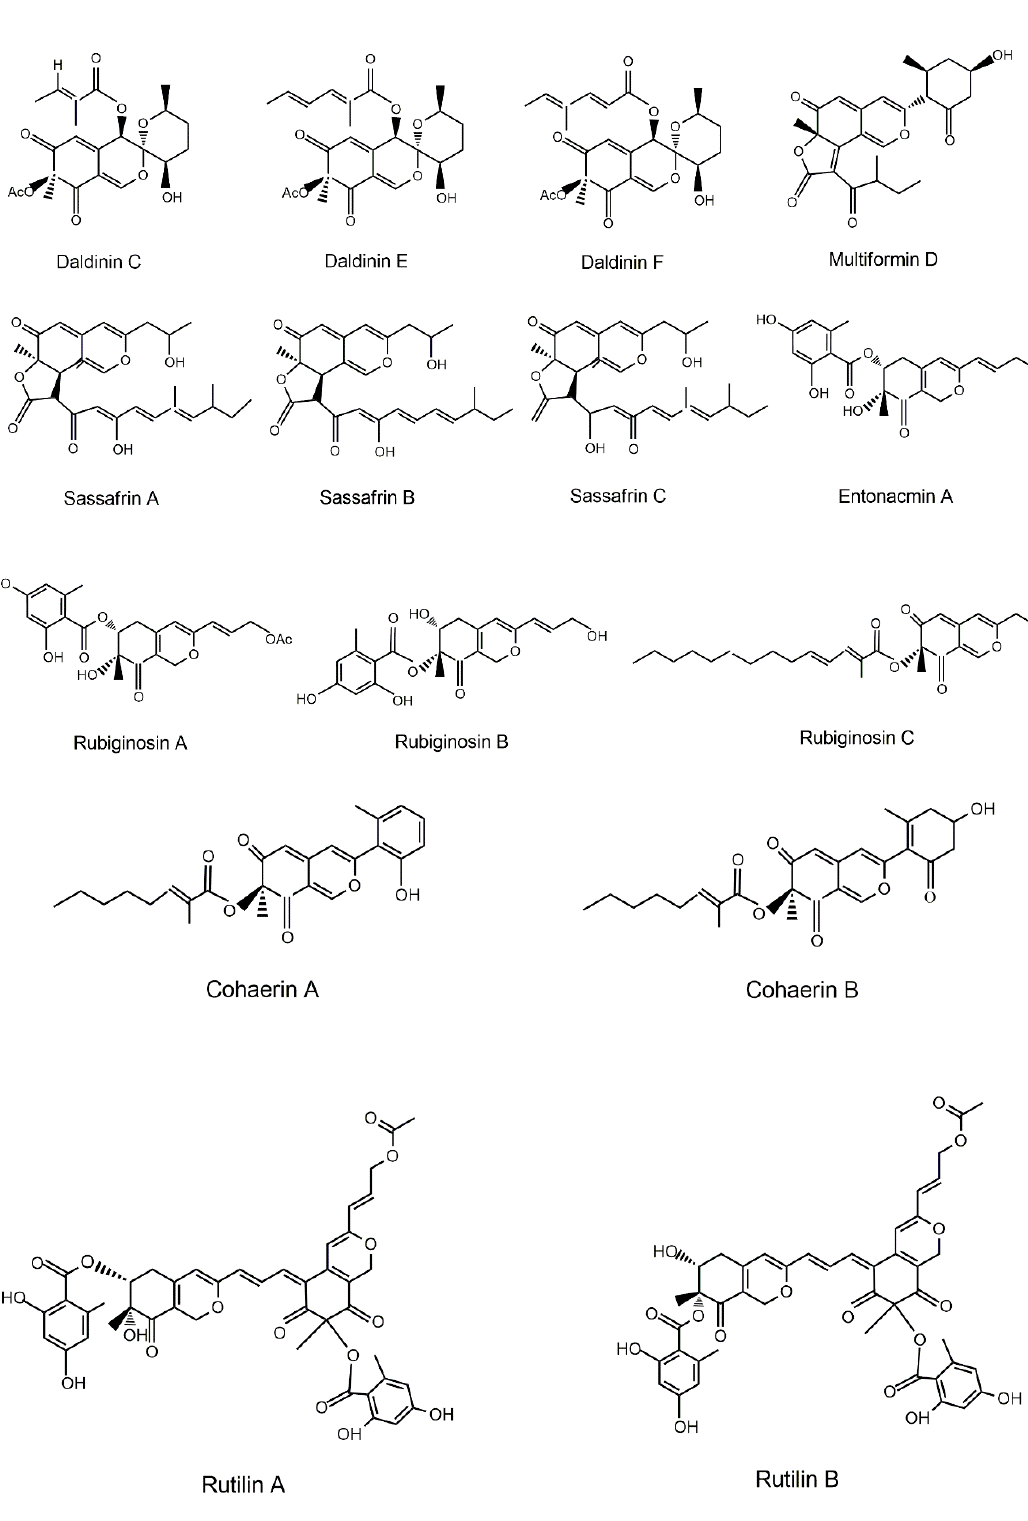
Figure 13. Structures of azaphilones.